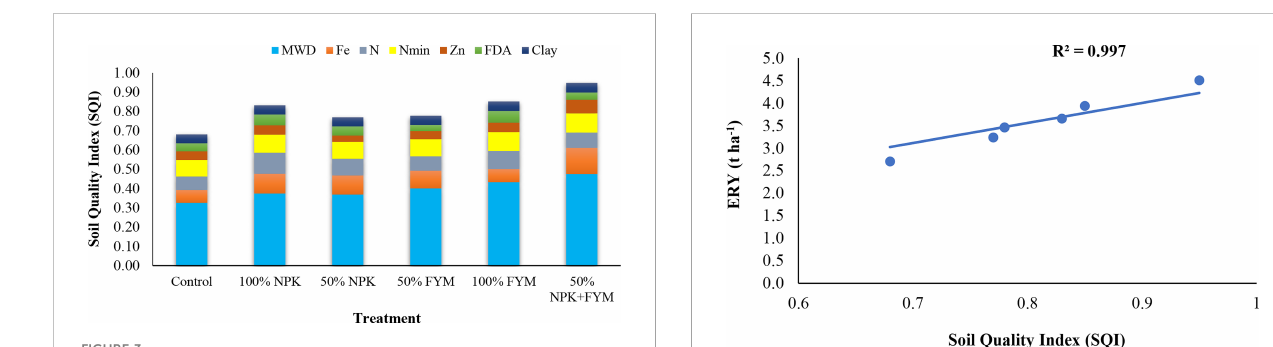
FIGURE 3 Contribution of various key indicators to PCA based SQI. FIGURE 4